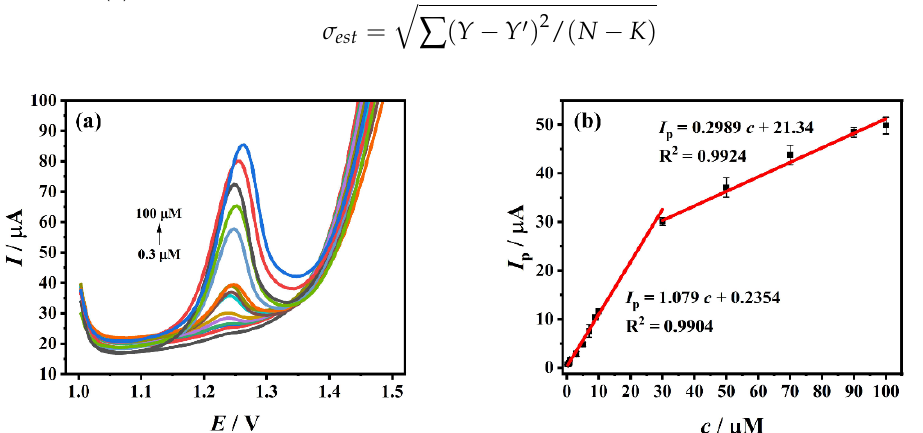
Figure 6. ( a ) DPV diagrams of different concentrations of TDF (0.3 µ M~100 µ M); ( b ) the linear relationship between the peak current and TDF concentration in the range of 0.3 µ M~30 µ M and 30 µ M~100 µ M.